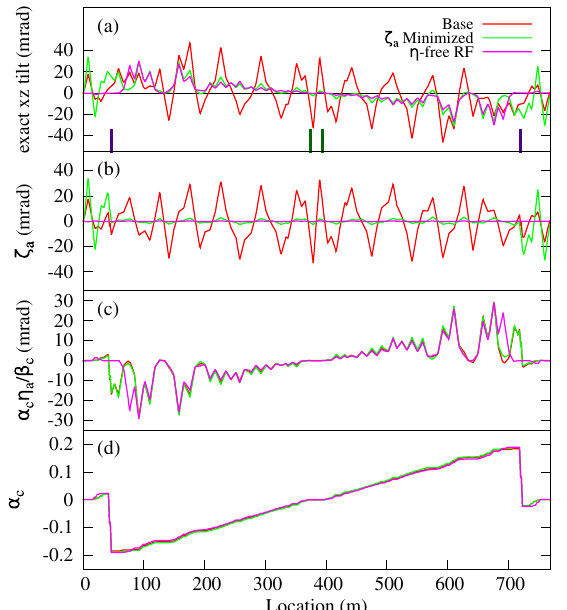
FIG. 4. For lattices with 6.3 MV total rf voltage: (a) Tilt of beam in xz plane calculated from major axis of projected beam envelope. Purple bars indicate the location of the two pairs of RF cavities. Green bars indicate the location of horizontal beam size monitors. (b) Crabbing contribution from 1st term in Eq. (38). (c) Crabbing contribution from 2nd term in Eq. (38). (d) Longitudinal Twiss parameter α c .